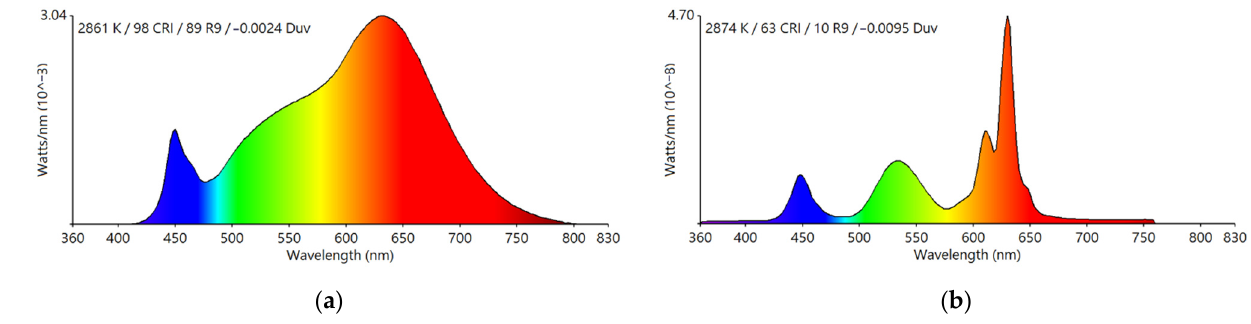
Figure 29. ( a ) Lighten Corp. Hi-COB LED 2850 K ( b ) iPhone X panel light source 2850